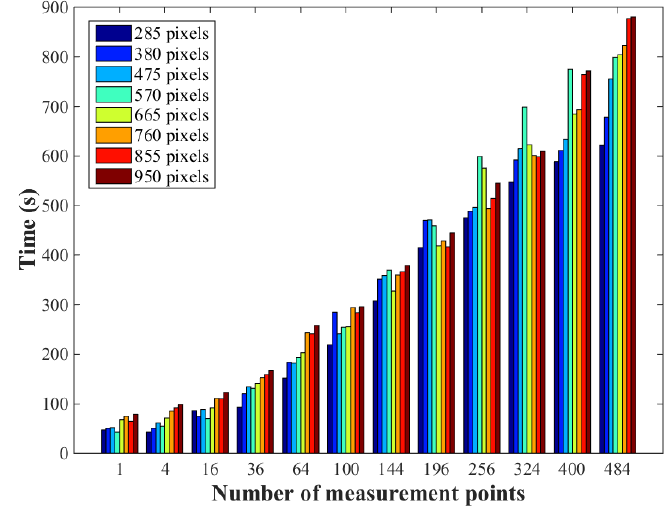
Figure 8. Execution time of optical-turbulence error mitigation for different targets.